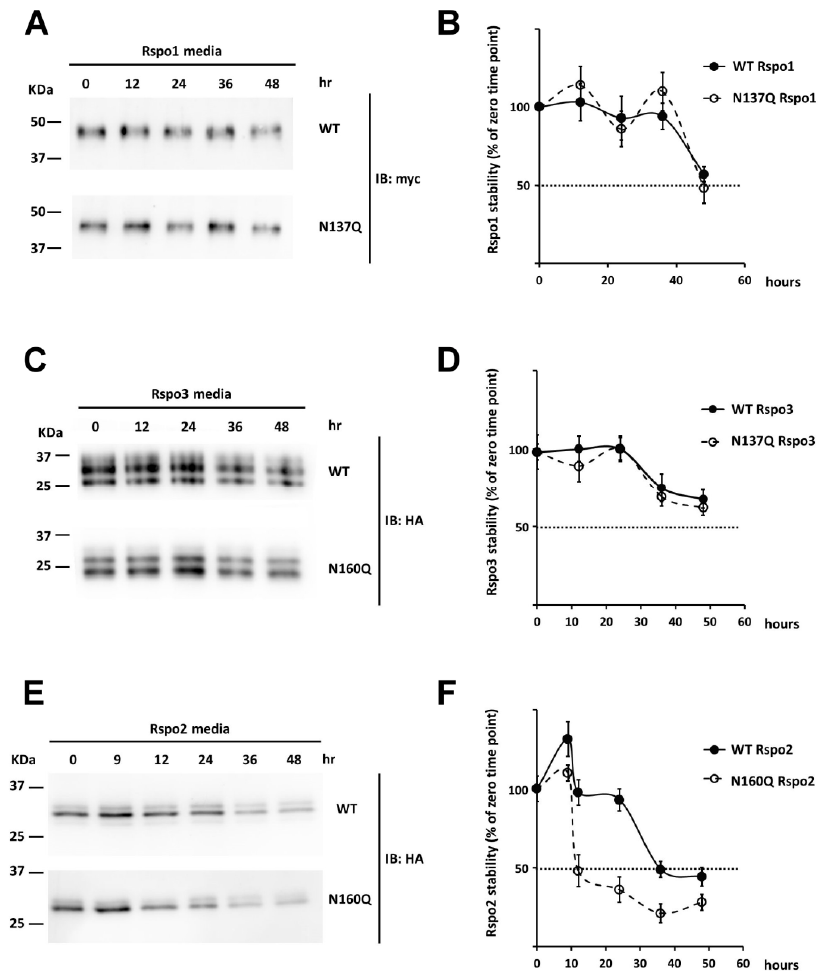
Figure 9. Effect of N-glycan on the stability of secreted Rspo1, 2 and 3. ( A , C , E ) Conditioned media containing WT Rspos and their variants were incubated at 37 °C for the indicated time points prior to Western blot analysis; ( B , D , F ) Quantification of the intensity for WT Rspos and their variants at each time point was compared to the level of Rspo (100%) at the starting time (0 h). Error bars indicated the SD.